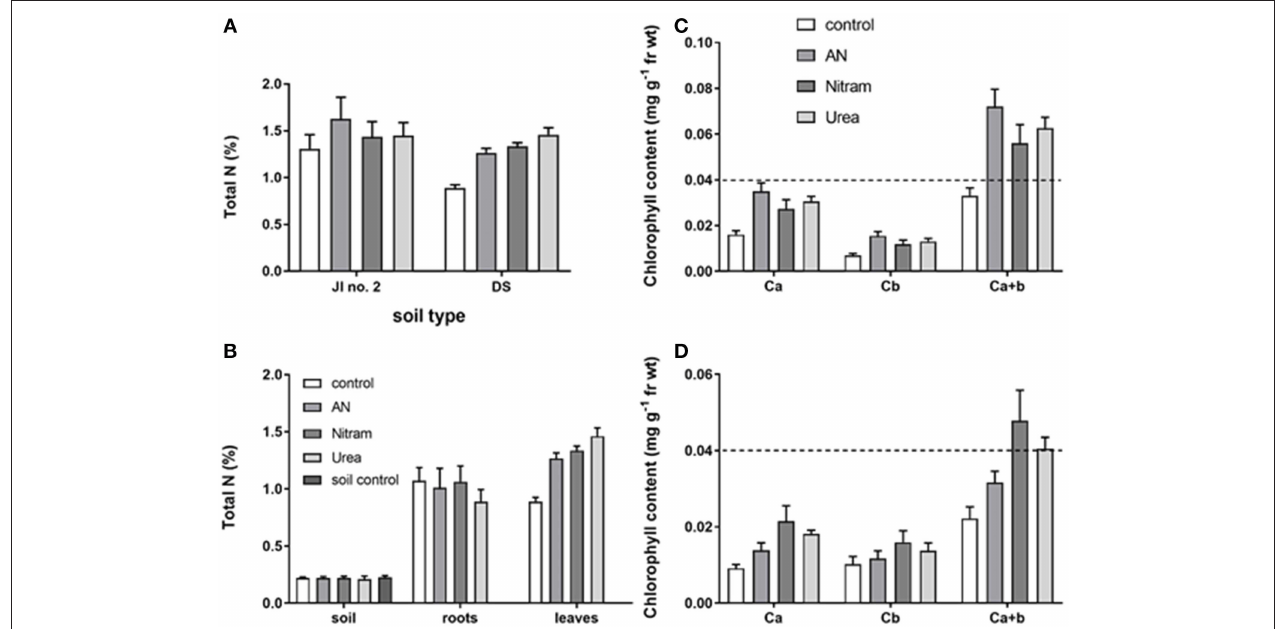
FIGURE 9 | Total leaf N in plants grown in JI no. 2 under different fertilizer treatments (A) ; Total soil, root and Leaf N of plants grown in DS, together with a soil only control (B) ; corresponding leaf chlorophyll content of plants in JI no. 2 (C) and DS (D) . (Statistics in Table 3 and Supplementary Information ). Dashed line shows equivalent position on y axis for